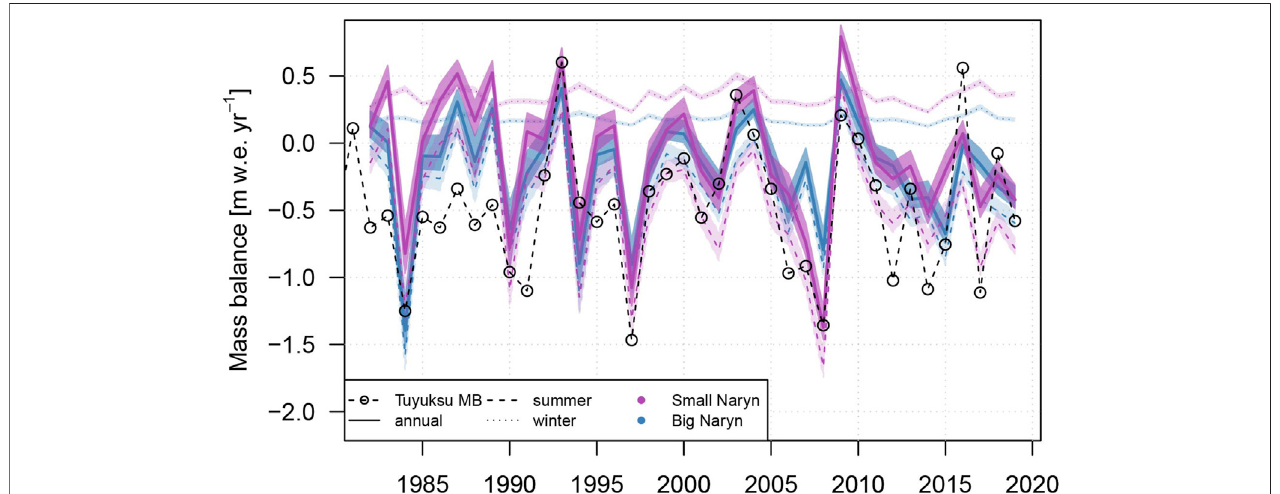
FIGURE 5 | Calculated seasonal and annual mass balance for glaciers in the Small and Big Naryn catchments. Long-term observed mass balance series from the Tuyuksu glacier is plotted for comparison (circles).